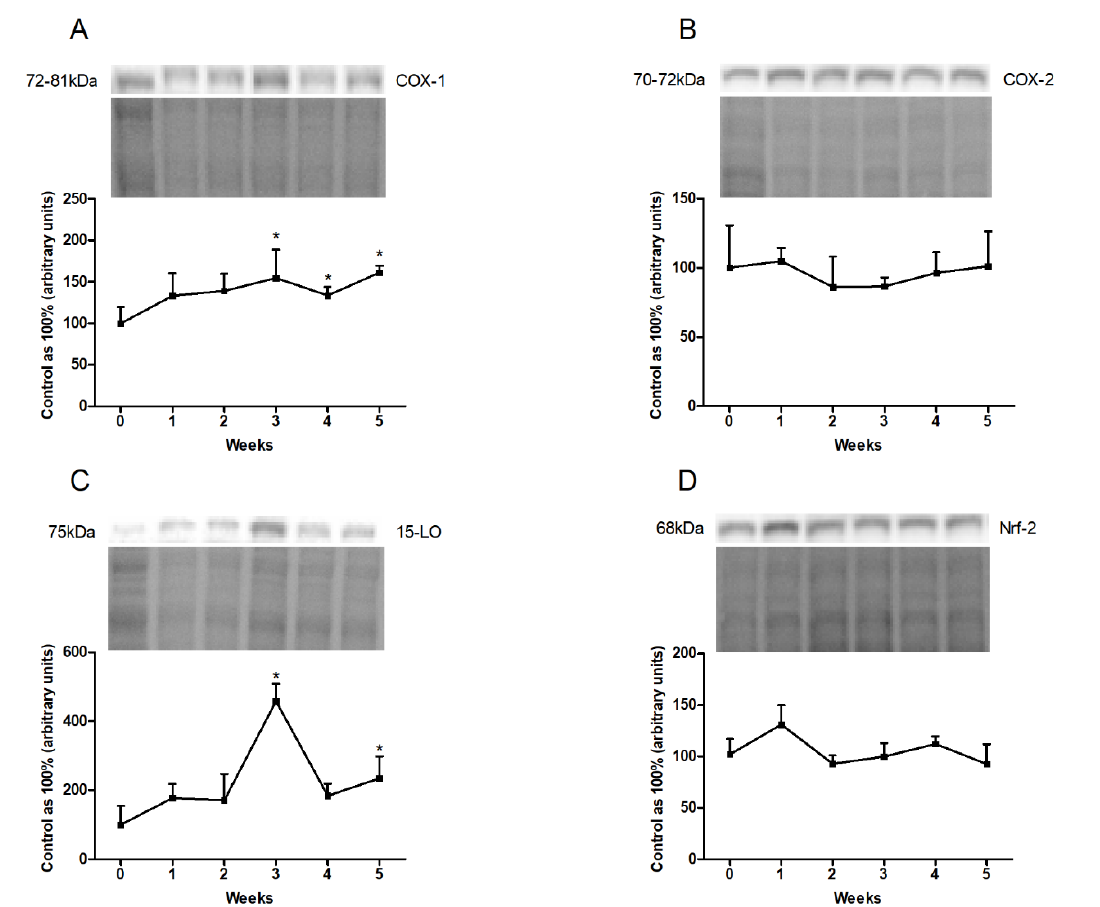
Figure 4. Representative Western blots illustrating the expression of proteins from eicosanoid and prostanoid synthesis pathways, i.e., ( A ) cyclooxygenase-1 (COX-1), ( B ) cyclooxygenase-2 (COX-2), ( C ) 15-lipoxygenase (15-LO) and ( D ) nuclear factor erythroid 2—related factor 2 (Nrf-2) in the liver homogenates. The protein expression was determined by the Western blotting method, as described in detail in the Materials and Methods section. The data are expressed as mean ± SD and are based on six independent determinations. * p < 0.05, significant difference compared with the control group (0 week).